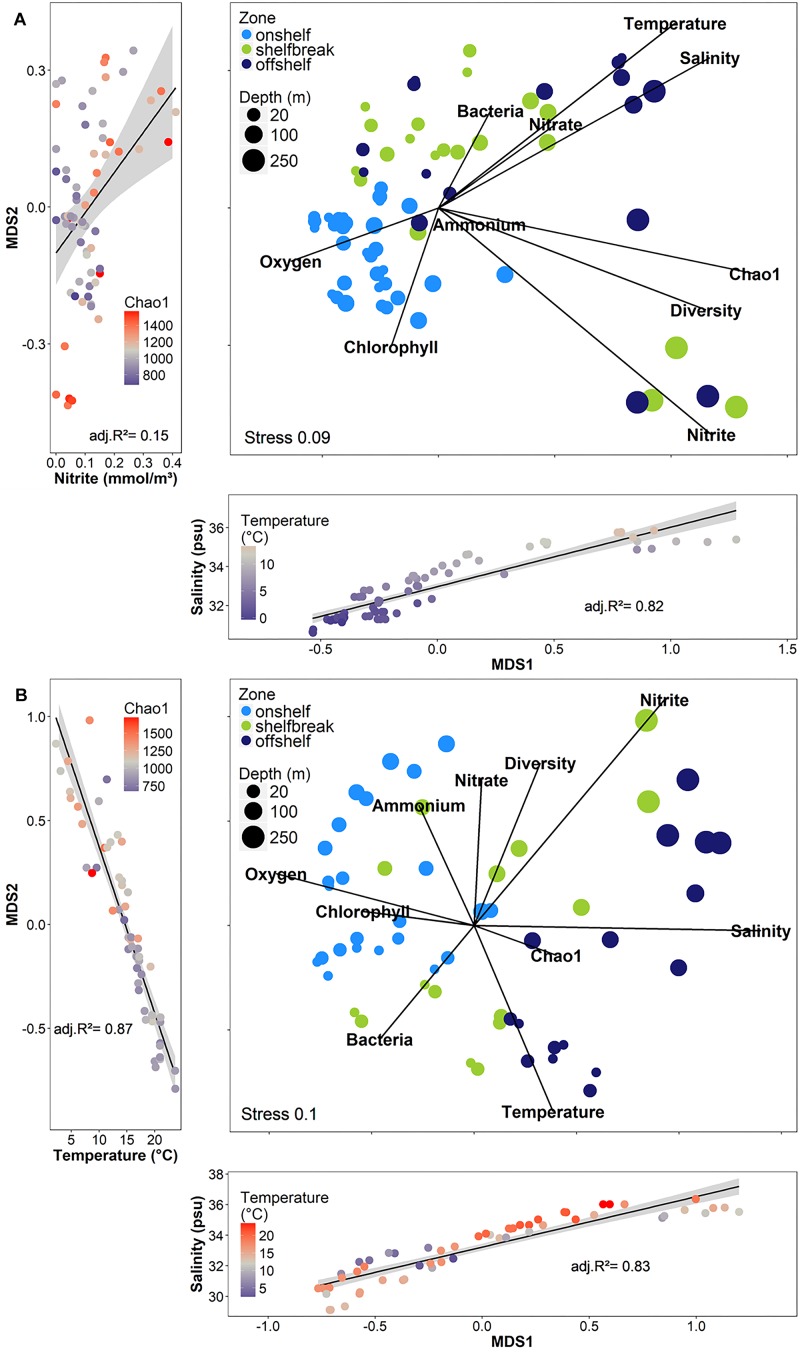
Non-metric multidimensional scaling analysis (NMDS) of Hellinger-transformed free-living OTU abundance data using the Bray–Curtis dissimilarity from 2014 across shelf transects in (A) spring (B) fall. The strong influences of temperature, salinity, and nitrite (spring only) on the axes of the NMDS are shown in the side and bottom plots. The sizes of the dots for the depth represent a gradual scale from 0 to 250 m.